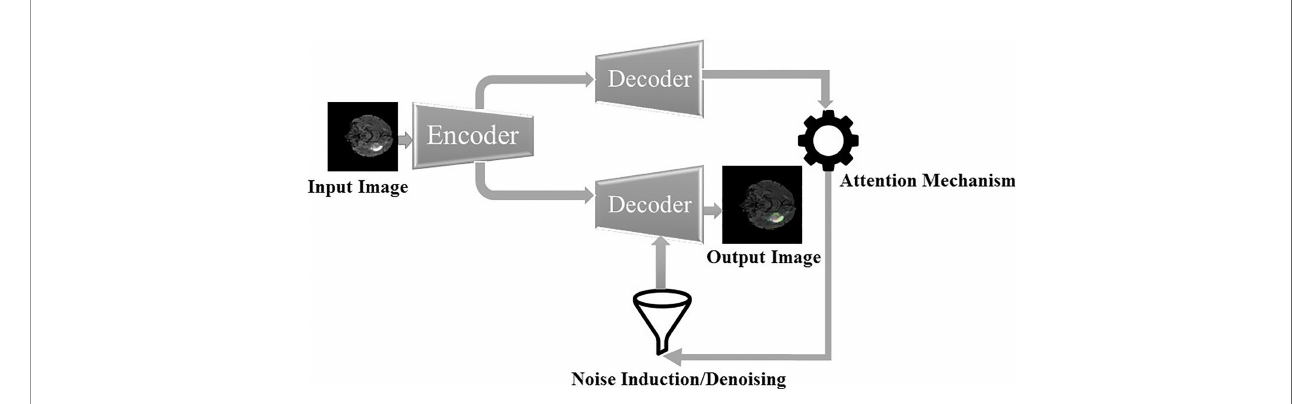
FIGURE 1 | Overview of the